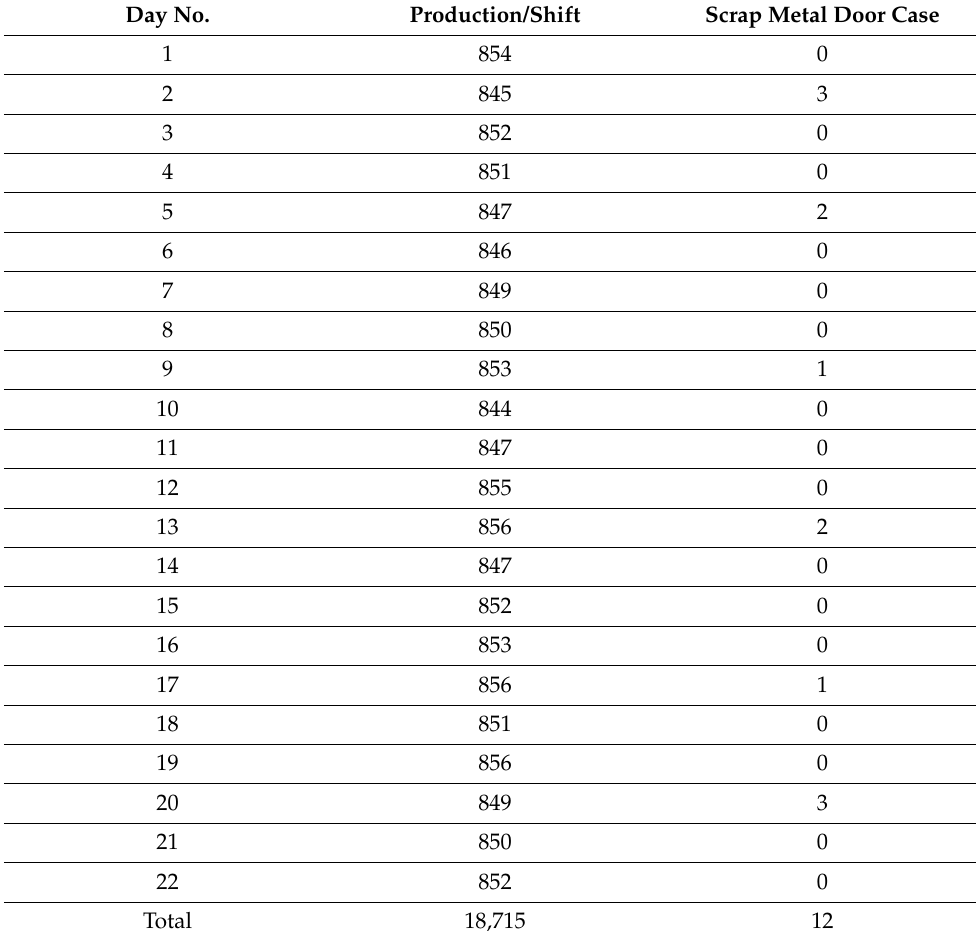
Table 9. The number of scraps obtained after the implementation of the solutions. Day No. Production/Shift Scrap Metal Door